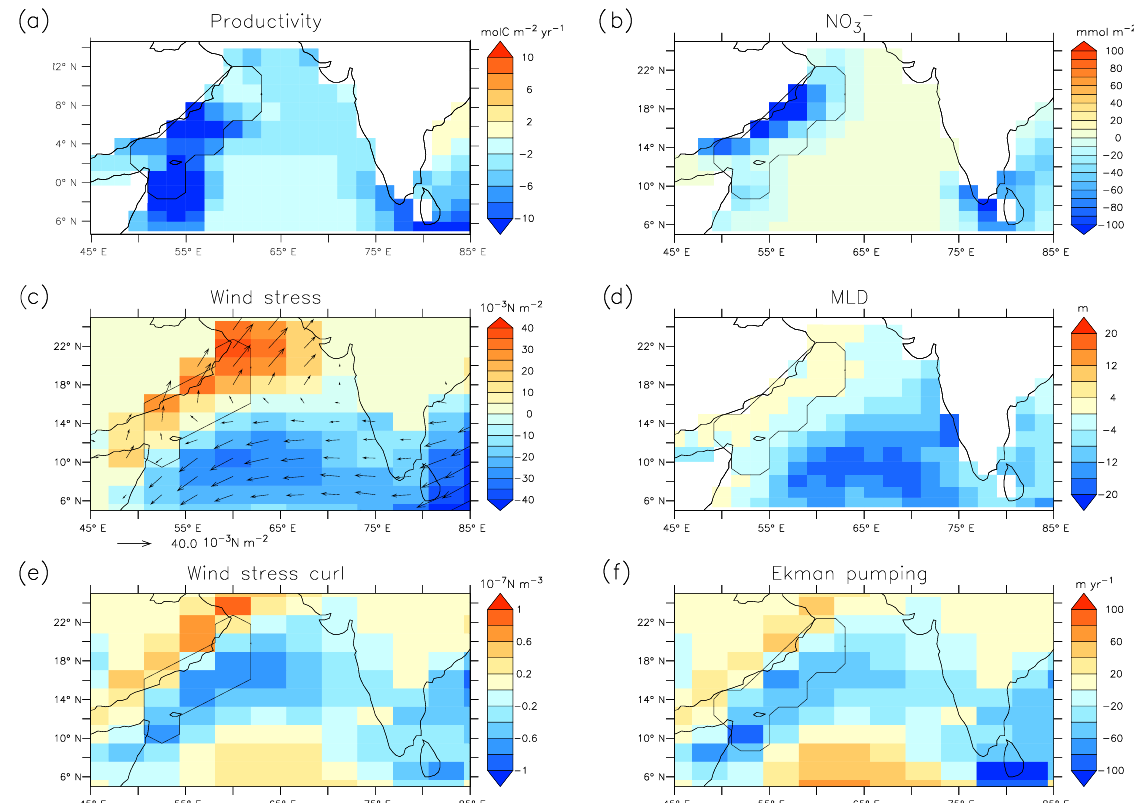
Figure 6. Boreal summer mean differences between EH and CTRL for (a) total primary productivity (TPP, molCm − 2 yr − 1 ) integrated over the whole water column, (b) NO − concentration (mmolm − 2 ) integrated in the first 30m of the water column, (c) wind stress intensity 3 (Nm − 2 ) and direction (arrows), (d) mixed-layer depth (MLD, m), (e) wind stress curl intensity (10 − 7 Nm − 3 ), and (f) Ekman pumping (myr − 1 , positive upward). The black contour in each panel represents the coastal area on which we averaged the variables throughout the text. Coastal areas for atmospheric and oceanic variables differ slightly because of the different model